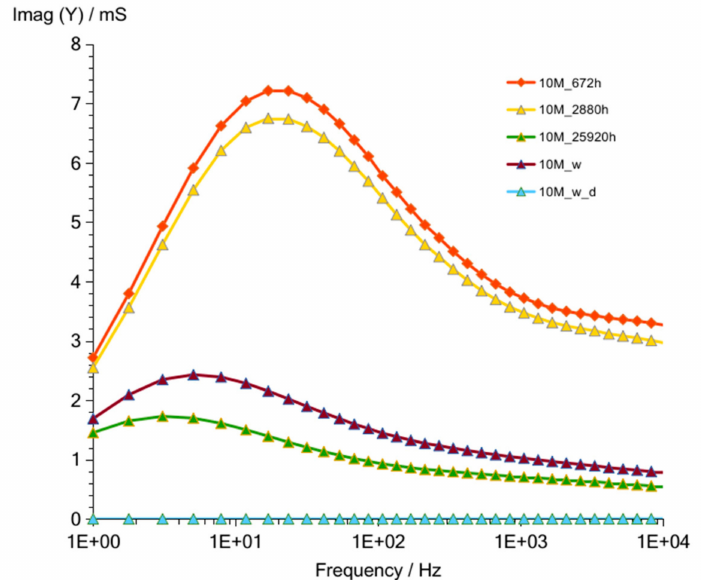
Figure 10. Susceptance of G10M geopolymer concrete taken after 672 to 25,920 h from starting polymerization after removing conductive ions (G10M_w) and drying concrete